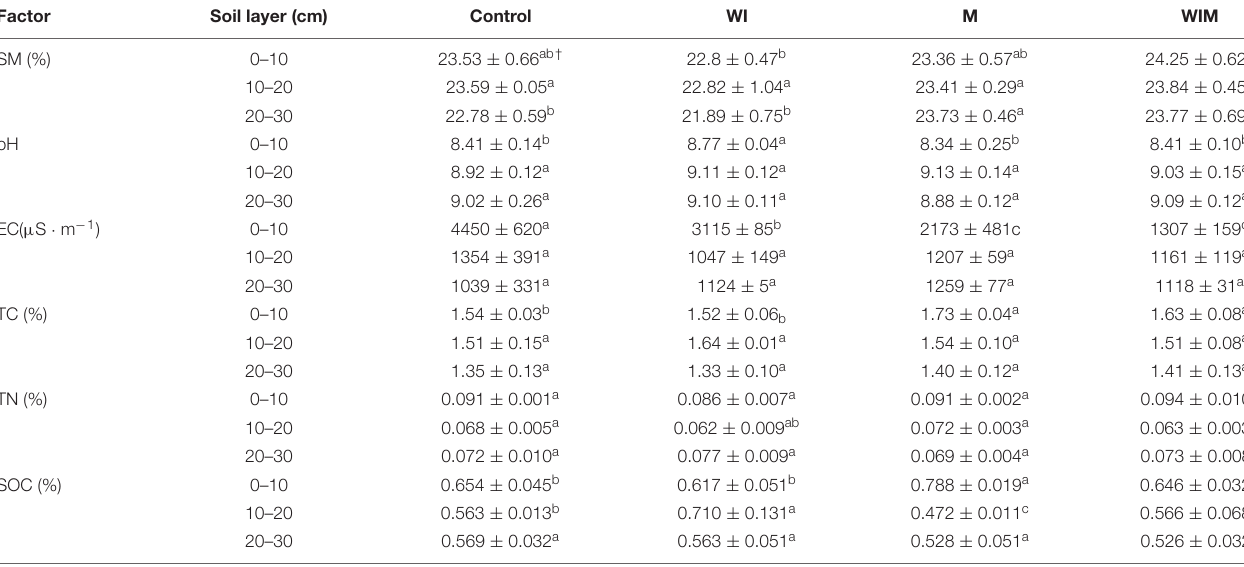
TABLE 1 | Soil properties in different amelioration treatments. Factor Soil layer (cm) Control WI M WIM SM